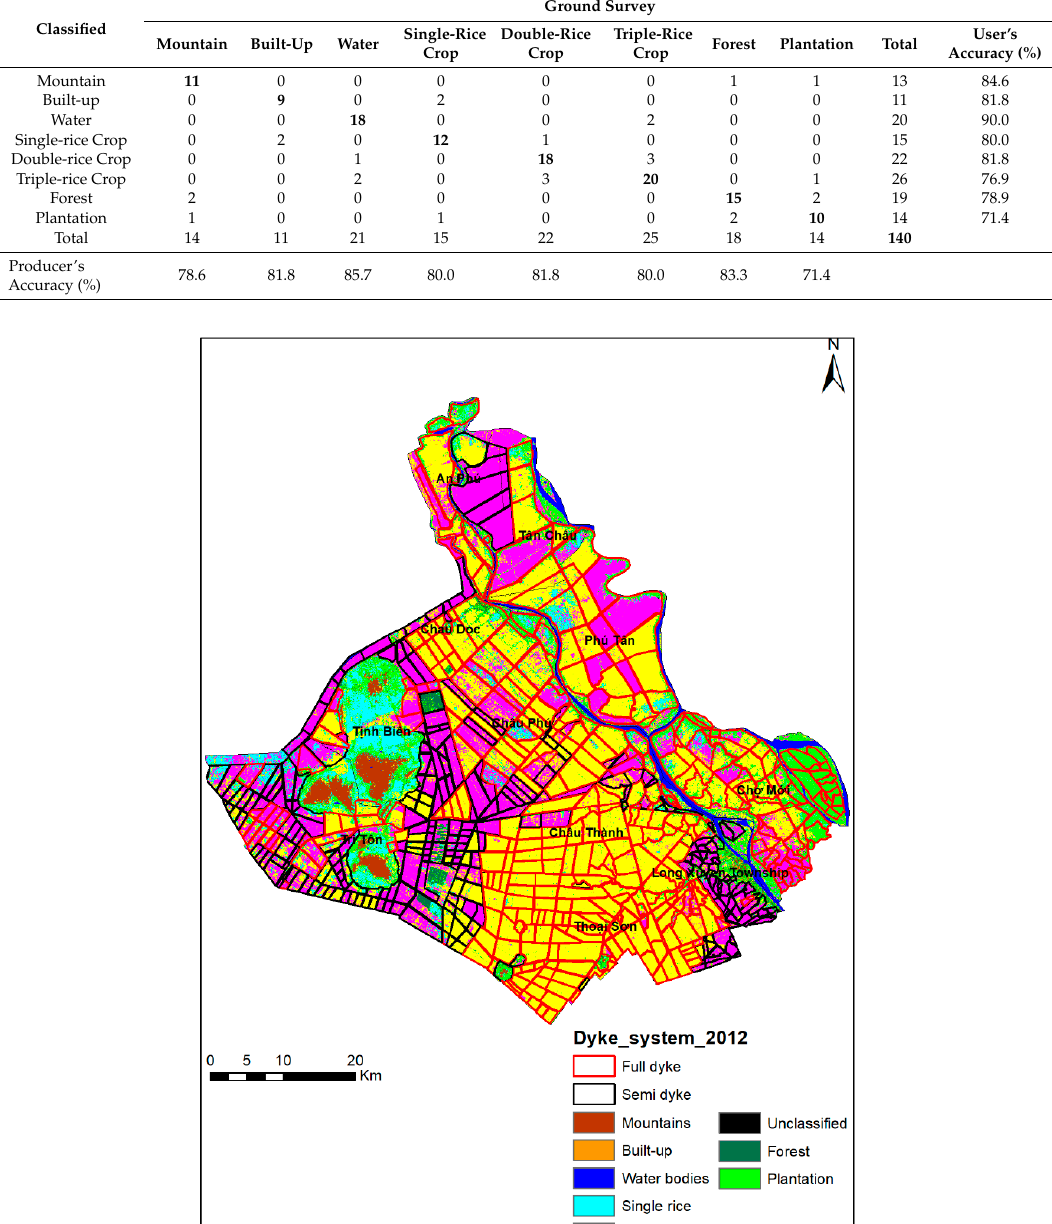
Table 3. Confusion matrix for accuracy assessment.